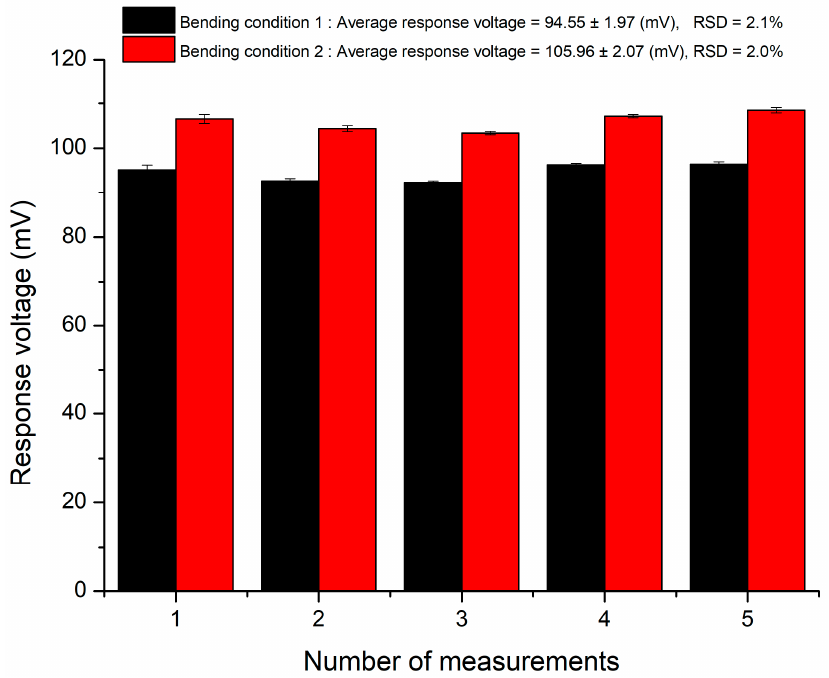
Figure 12. The repeatability of the sensors under two different bending conditions.